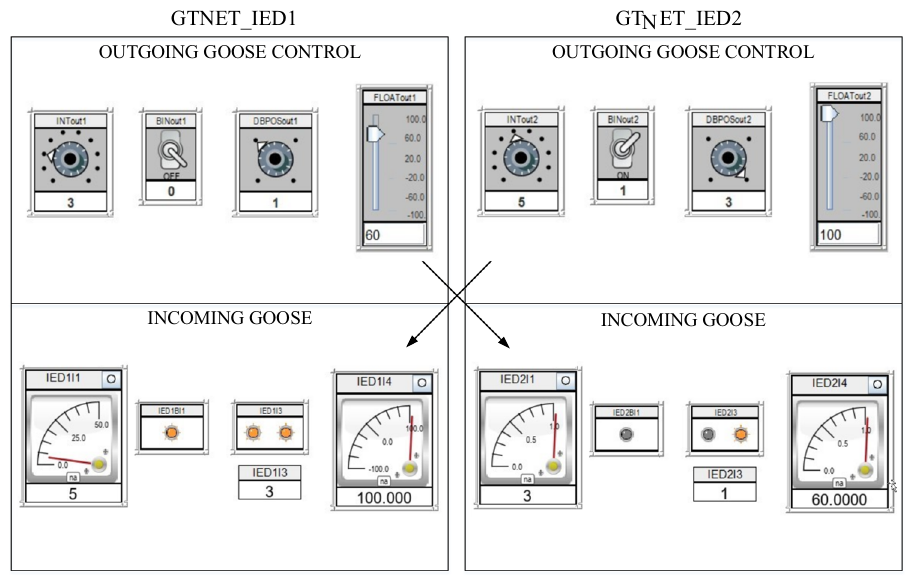
Figure 3. RTDS runtime for GOOSE communication between IED 1 and IED 2 before the manipulation of packets by the attacker 6 .